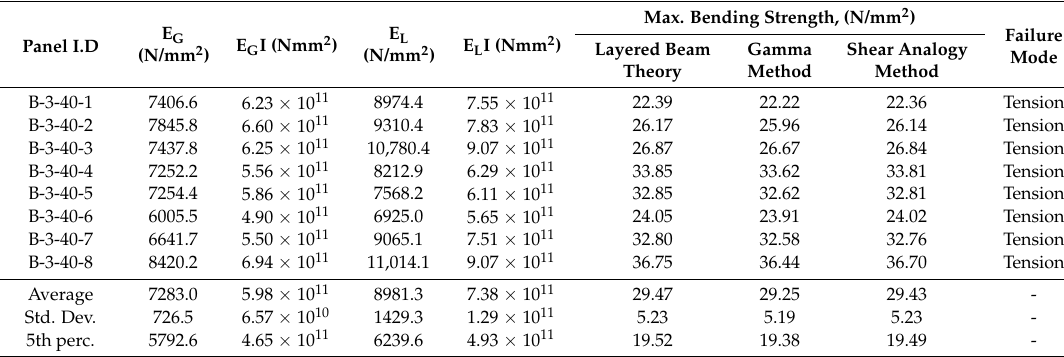
Table 4. Bending test results for three-layer B-3-40